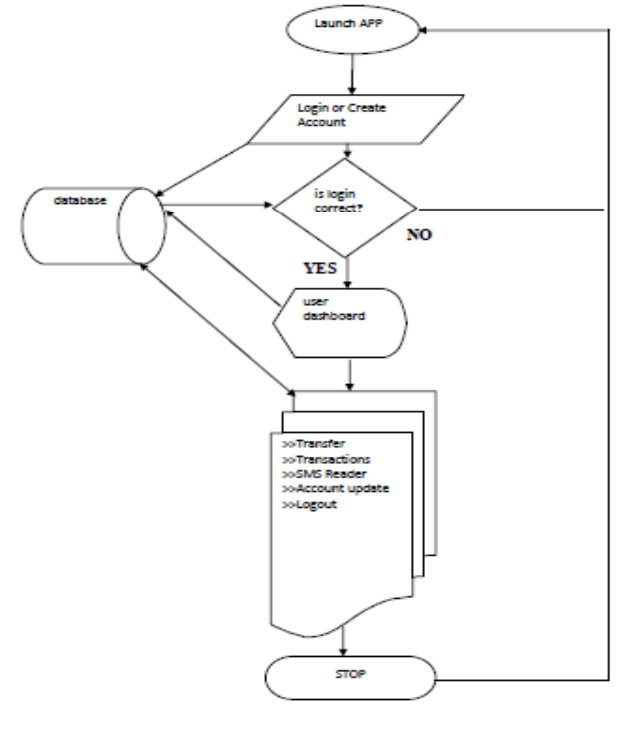
Fig. 6. System Flow chart